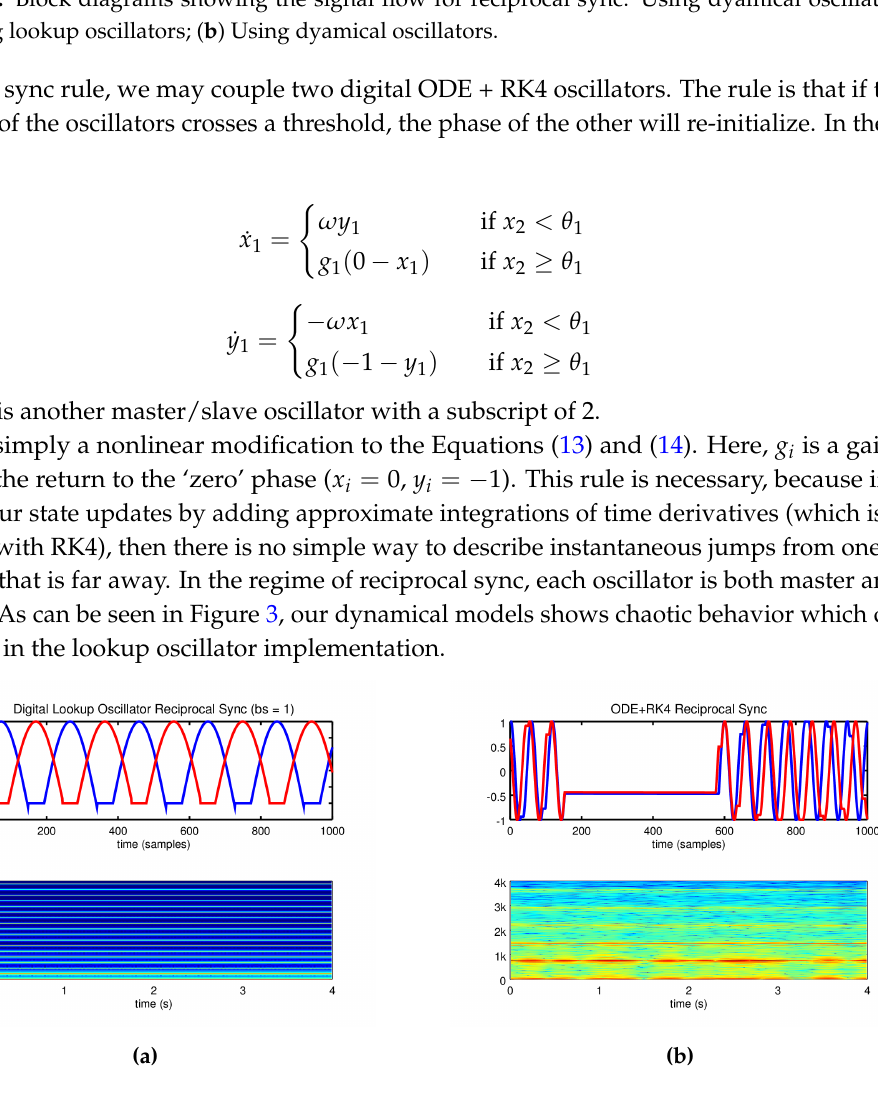
Figure 3. The output of ( a ) two digital lookup oscillators in a tight sync loop and ( b ) another pair given Equations (16) and (17) fed to the fourth order Runge-Kutta (RK4) method for solution. ( a ) 950 Hz and 900 Hz digital lookup oscillators in reciprocal sync. θ = 0.9; ( b ) The same parameters but using the dynamical model in Equations (16) and